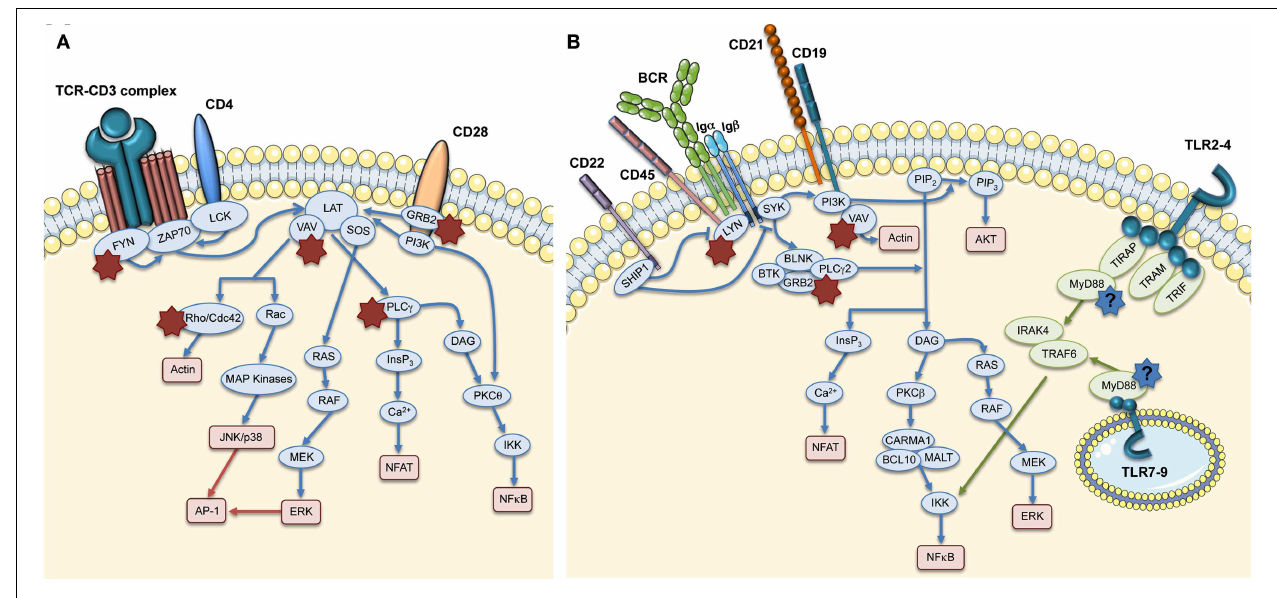
these pathways is indicated by stars close to interacting molecules: red stars show the interactions that are demonstrated, whereas the blue stars with question marks show hypothetical involvement ofWASP inTLR signaling